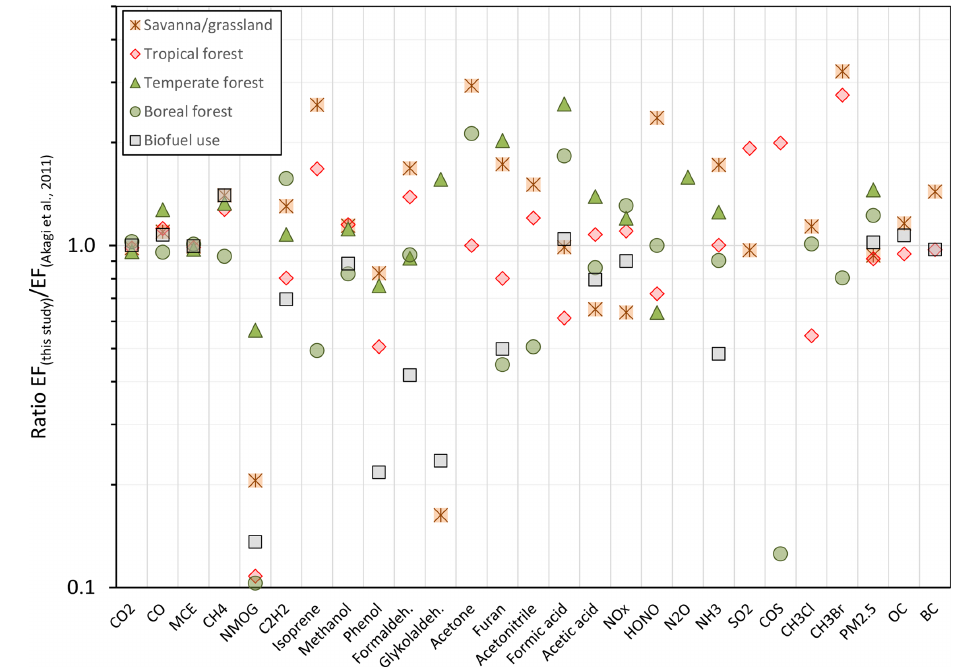
Figure 2. Comparison between the emission factors for selected species between this study and the values in Akagi et al.